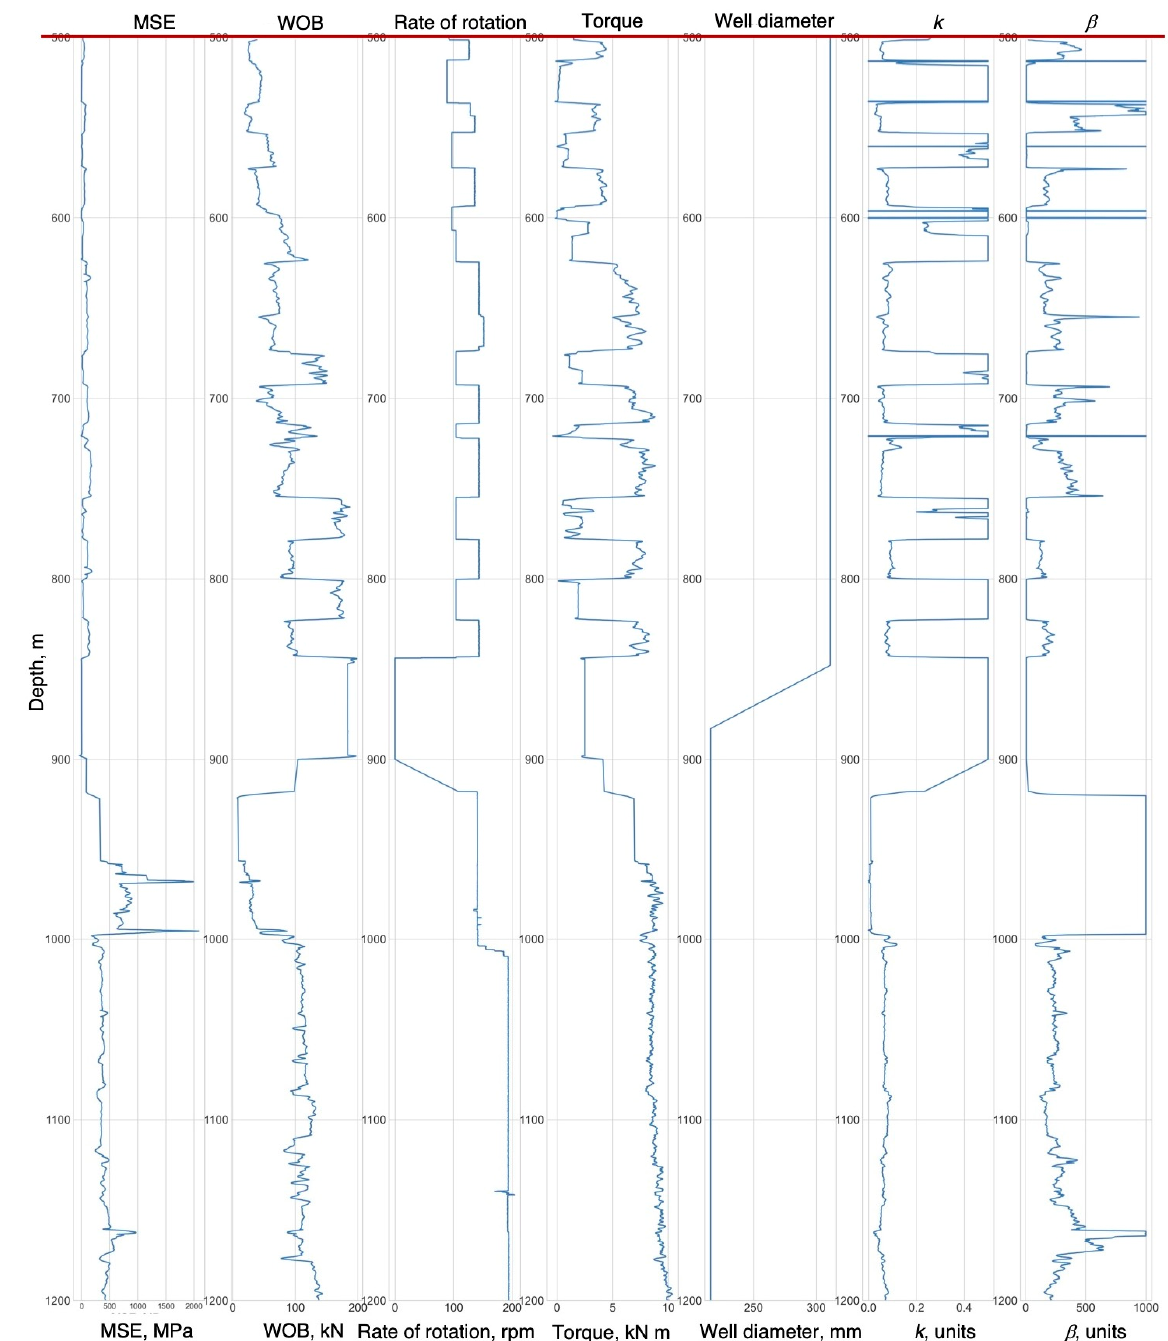
Figure 11. The results of the calculation.